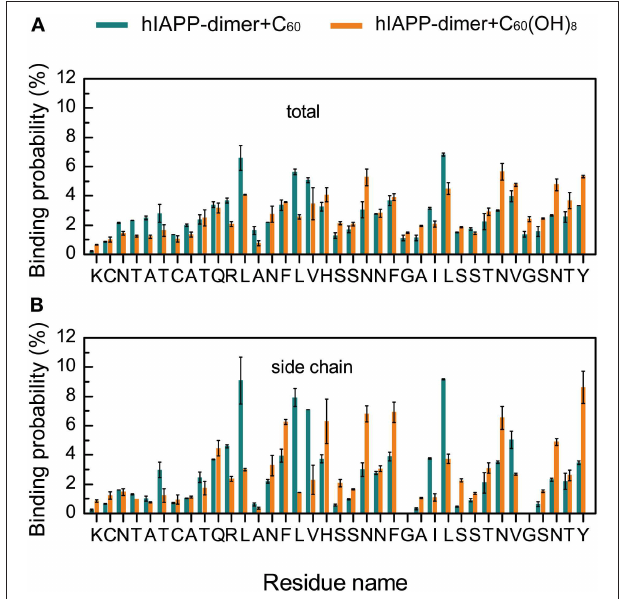
FIGURE 4 | Binding probabilities of C 60 /C 60 (OH) 8 with hIAPP dimer. Binding probabilities of C 60 /C 60 (OH) 8 with all the atoms (A) and the side chain atoms (B) of each residue in hIAPP-dimer + C 60 and hIAPP-dimer + C 60 (OH) 8